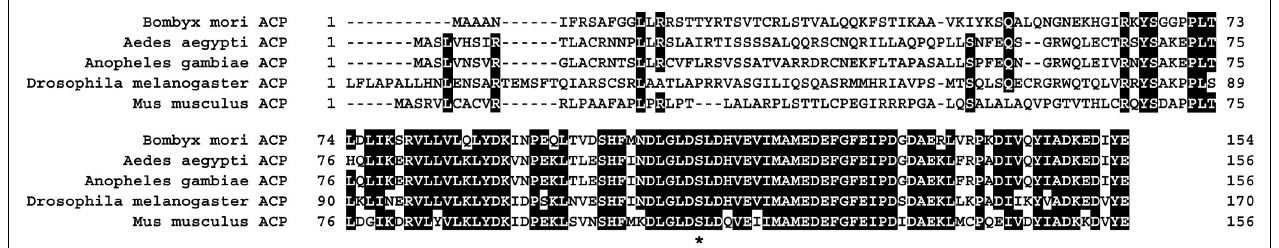
EAA07190, ADB57059, AAH92379). Numbering of each sequence begins at the predicted initiator methionine. Amino acid residues identical to the B. mori sequence are highlighted in black.The asterisk ( ∗ ) indicates the prosthetic group attachment site (Ser).